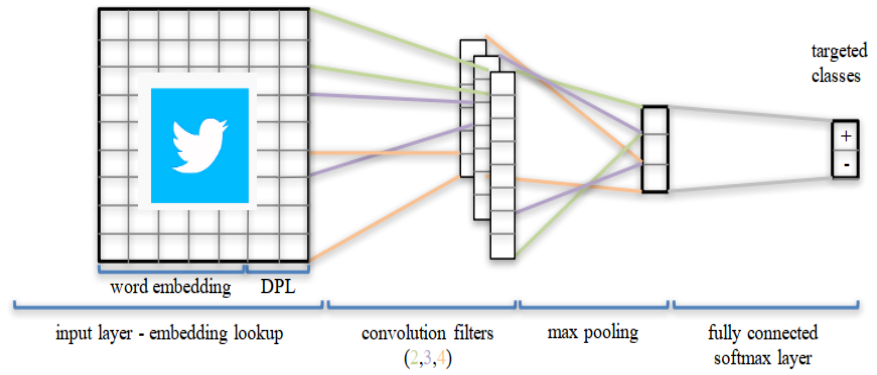
Figure 2. Typical CNN architecture adopted for the Twitter dataset classification purpose.